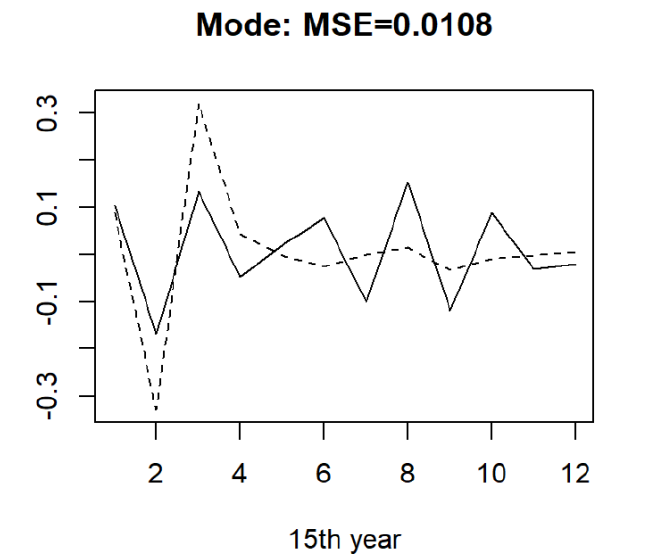
Figure 11. The curves of the true value (solid line) and FCM model (dotted line) with MSE =